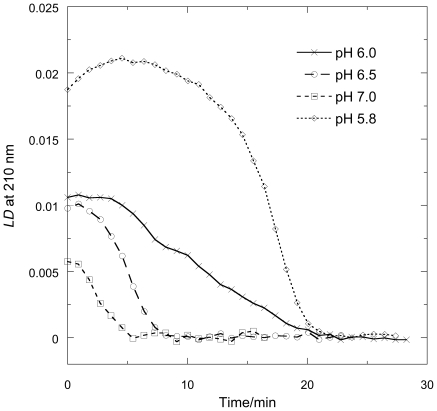

LD
210 nm of FtsZ.FtsZ (11 µM) in MES buffer (50 mM pH as indicated in figure), KCl (50 mM) and MgCl2 (10 mM) with addition GTP (0.2 mM).